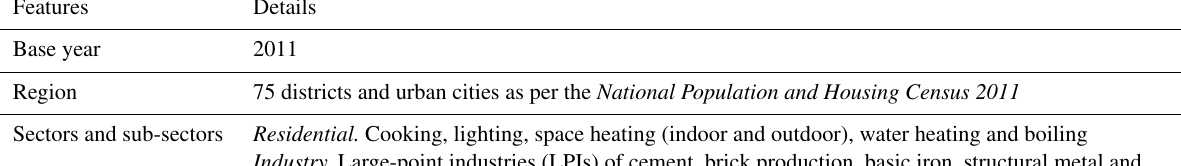
Table 1. Details about important features of the Nepal emission inventory (NEEMI).